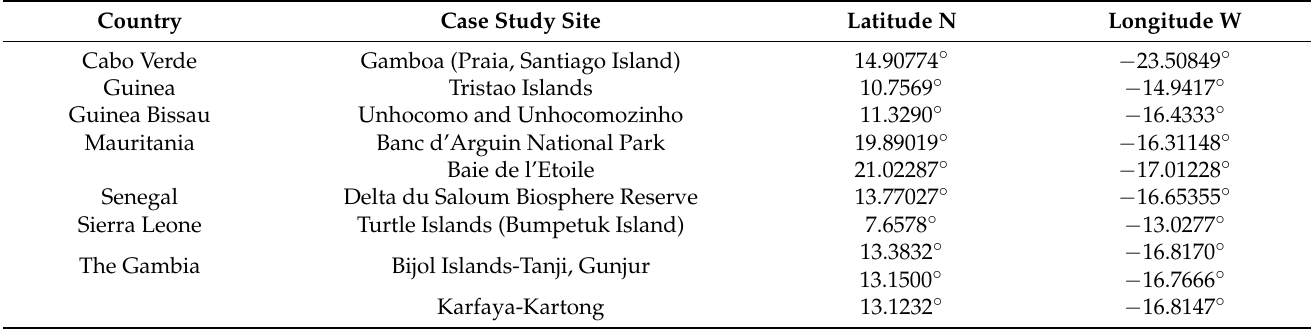
Table 1. Case study sites used to primarily document seagrasses in the region (countries in alphabeti- cal